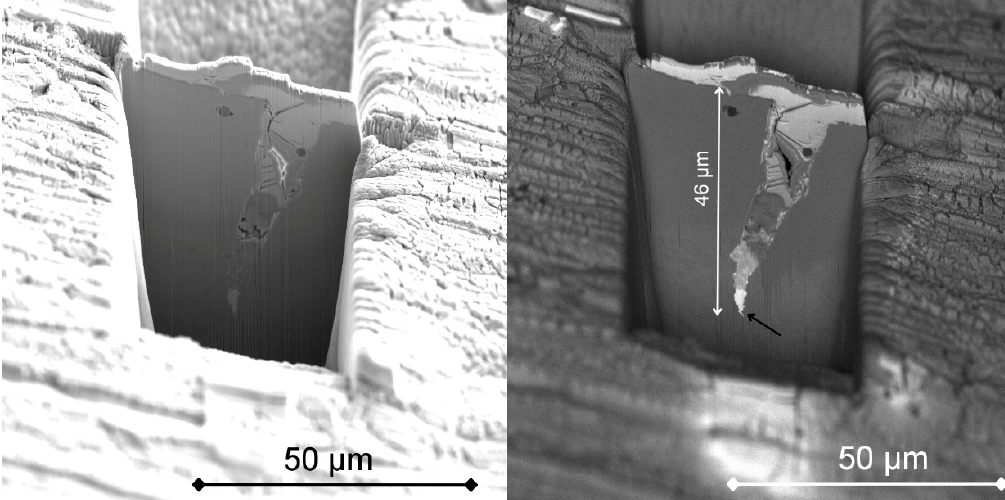
Figure 3. Secondary electron (SE) ( left ) and backscattered electron (BSE) ( right ) images of the investigated crack in the FIB cross-section (backside trench is prepared for further lamella lift-out). The crack is widely opened at the top and filled with liquid metal Pb-Bi on the sides and at the crack tip, as is indicated by the black arrow.